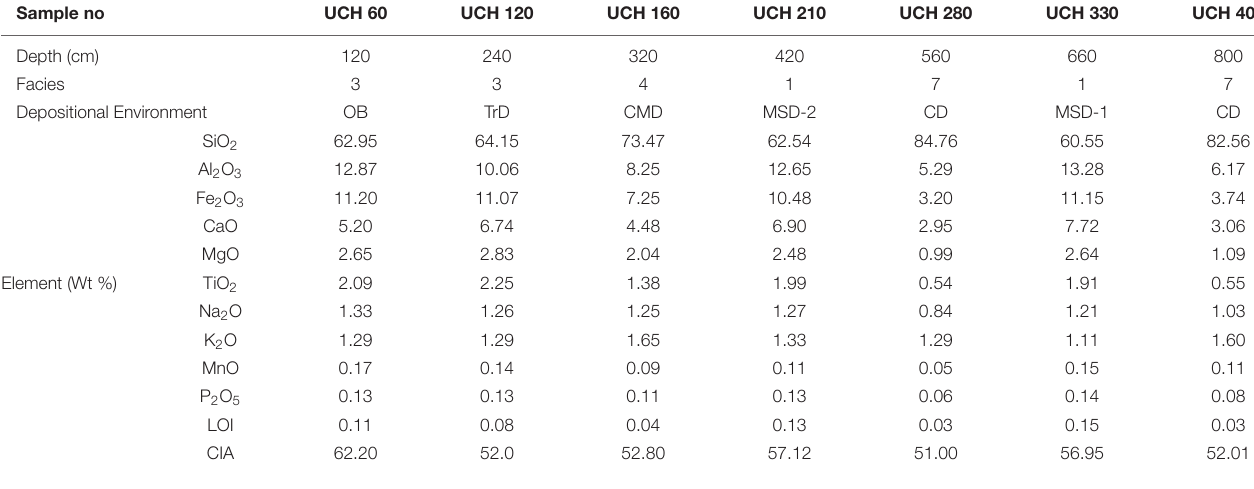
TABLE 4 | Major elemental geochemistry and CIA of